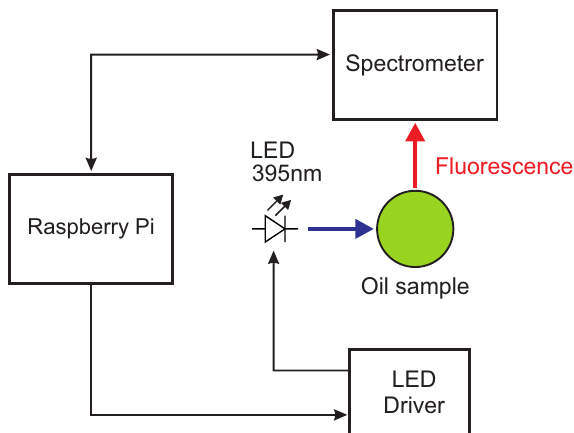
Figure 1. Schematics of the minimalist fluorescence sensor. Blue: Excitation light, red: Fluores- cence